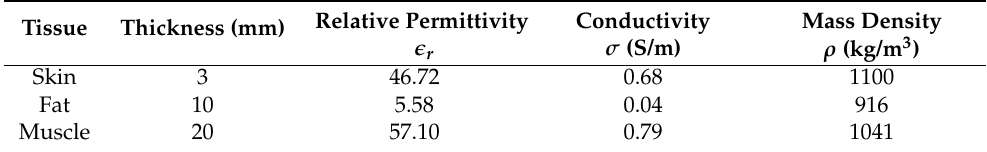
Table 1. Electric properties of human tissue at 403